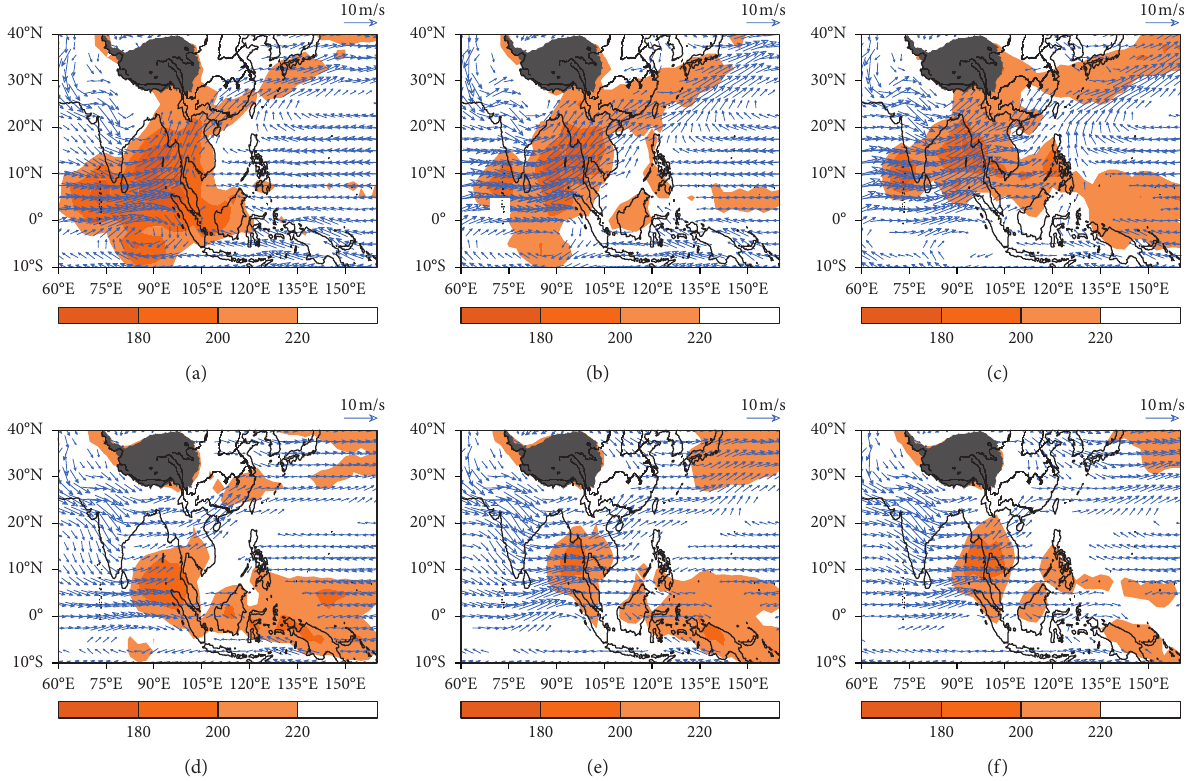
Figure 2: Composite evolution of OLR (W/m 2 , shadings) and 850 hPa wind (m/s, vectors) based on the SCSSM onset date in a typical year of the epoch 1979–93 (Top) and 1994–2016 (Bottom) from (a, d) one pentad before the monsoon onset ( P − 1), (b, e) during the monsoon onset ( P 0), and (c, f) one pentad after the monsoon onset ( P + 1).